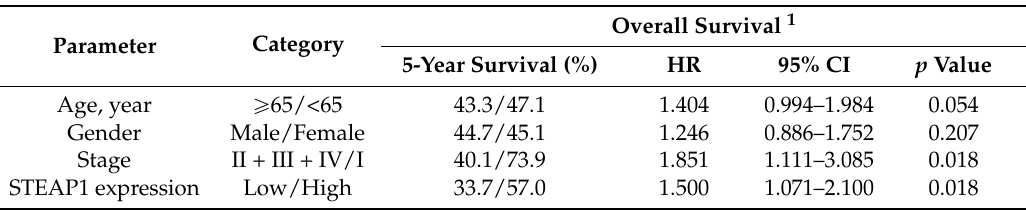
Table 3. Multivariate analysis of the influence of various parameters on overall survival in colorectal cancer patients.